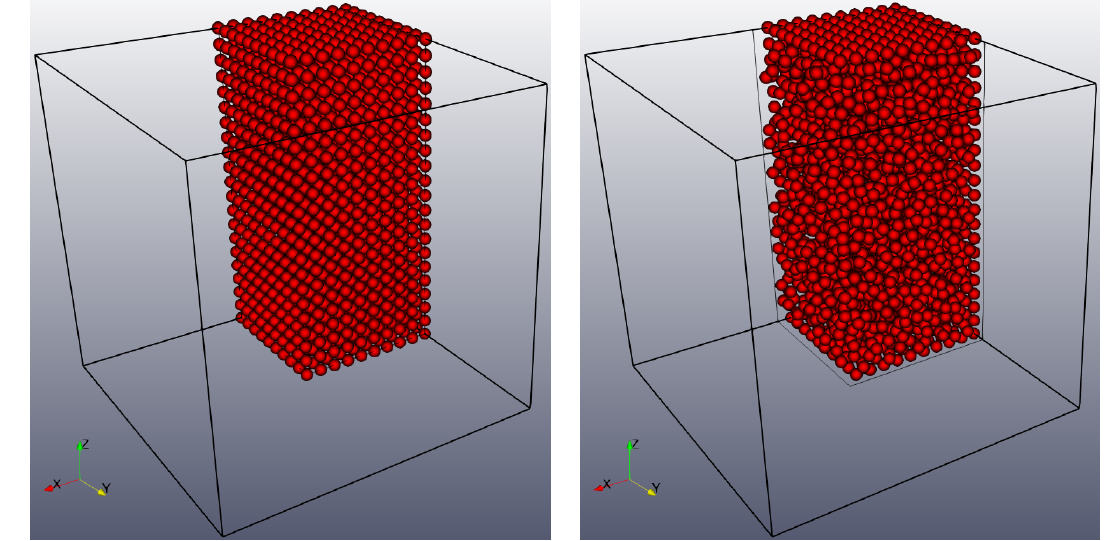
Figure 3. Uniform vs. random configuration of particles. Only a quarter of the cubic domain is clipped and shown for better